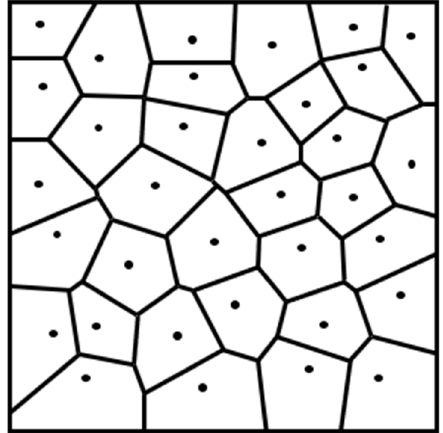
Figure 3. Schematic diagram of 2D Voronoi.